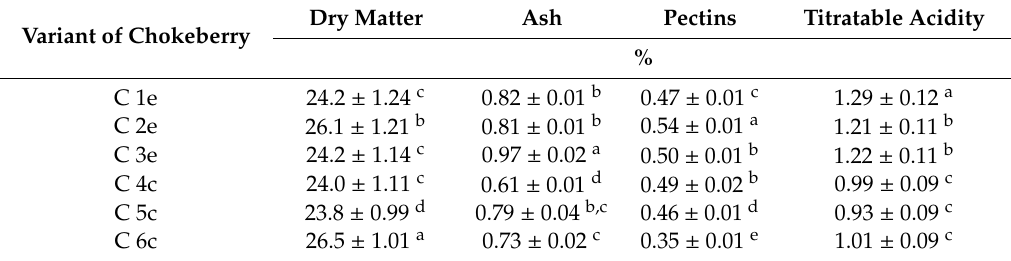
Table 1. Content of dry matter, ash, pectins, and acidity of chokeberry fruit. Variant of